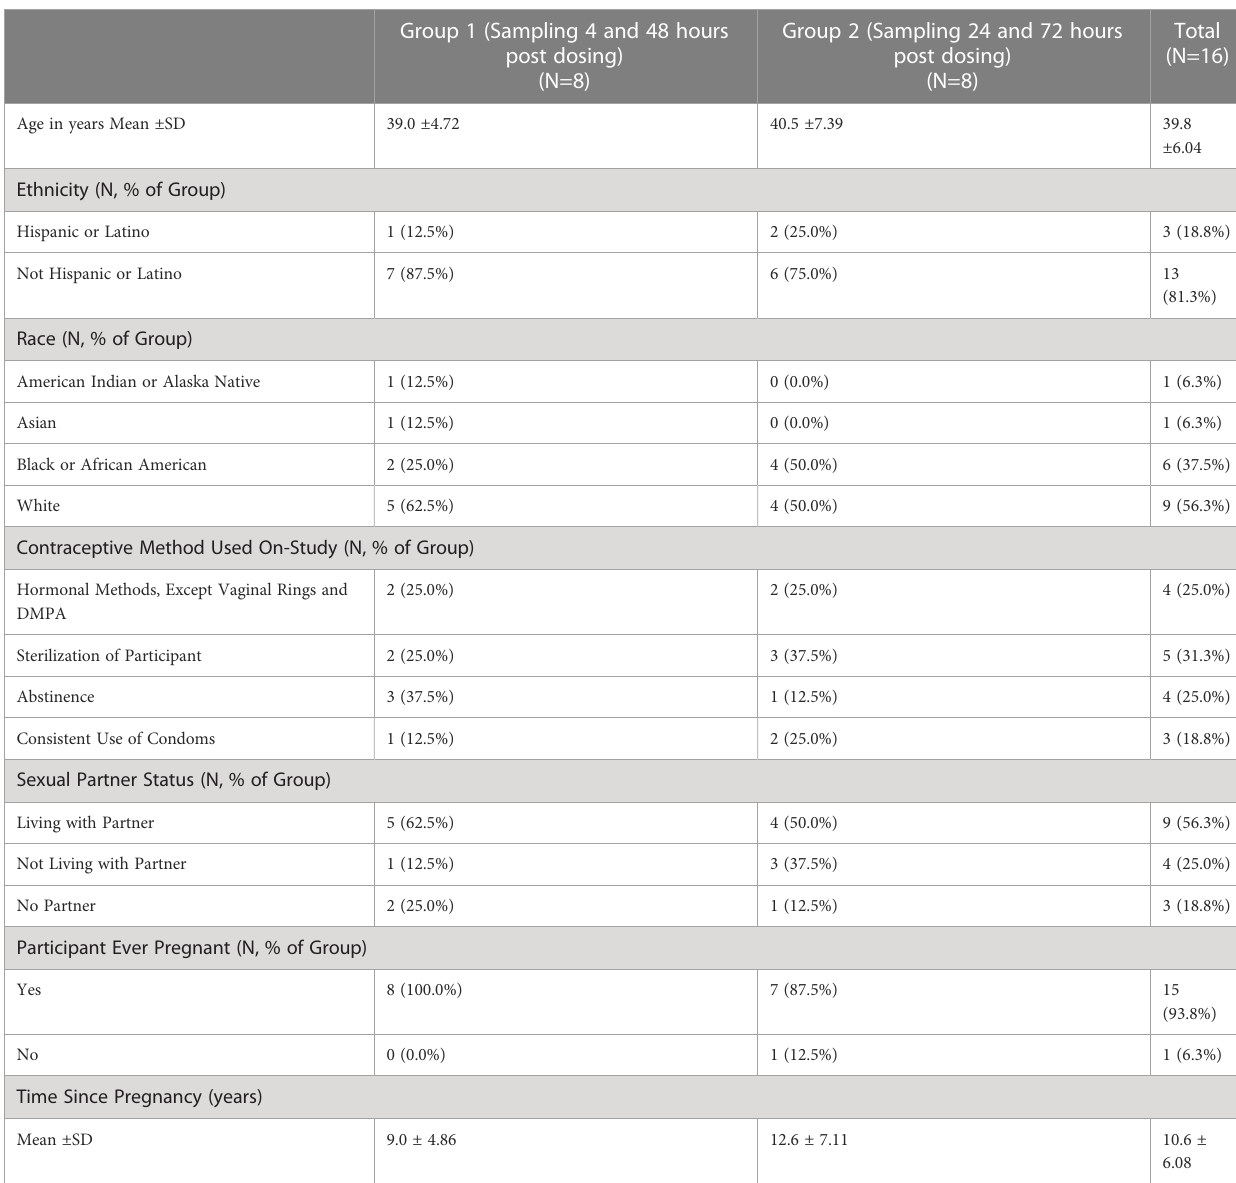
TABLE 1 CONRAD A18-146